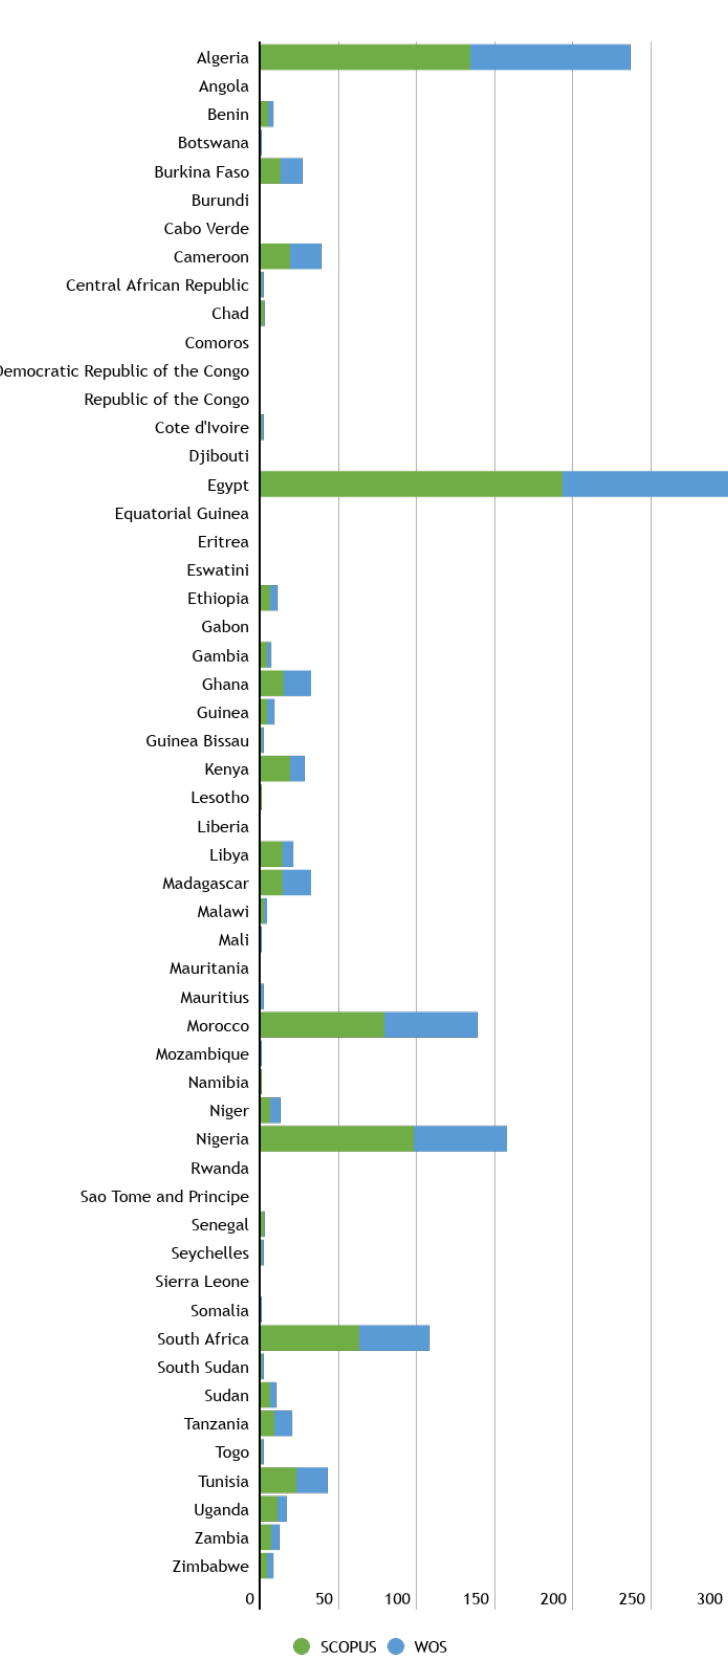
Figure 3. The number of “thermal comfort” documents including “name of the country” found in Scopus and WOS.